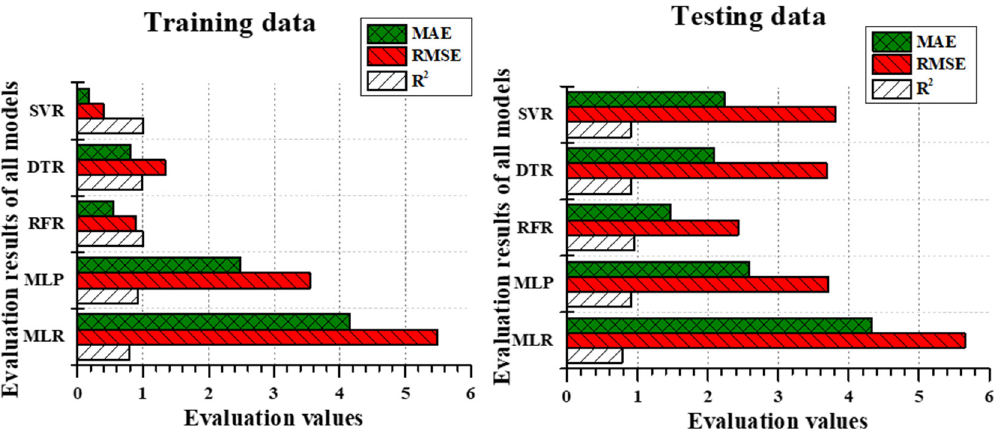
Figure 7. Training evaluation metric comparison between MLR, MLP, RFR, DTR, and SVR with S3 and training evaluation metric comparison between those models during IRH prediction.